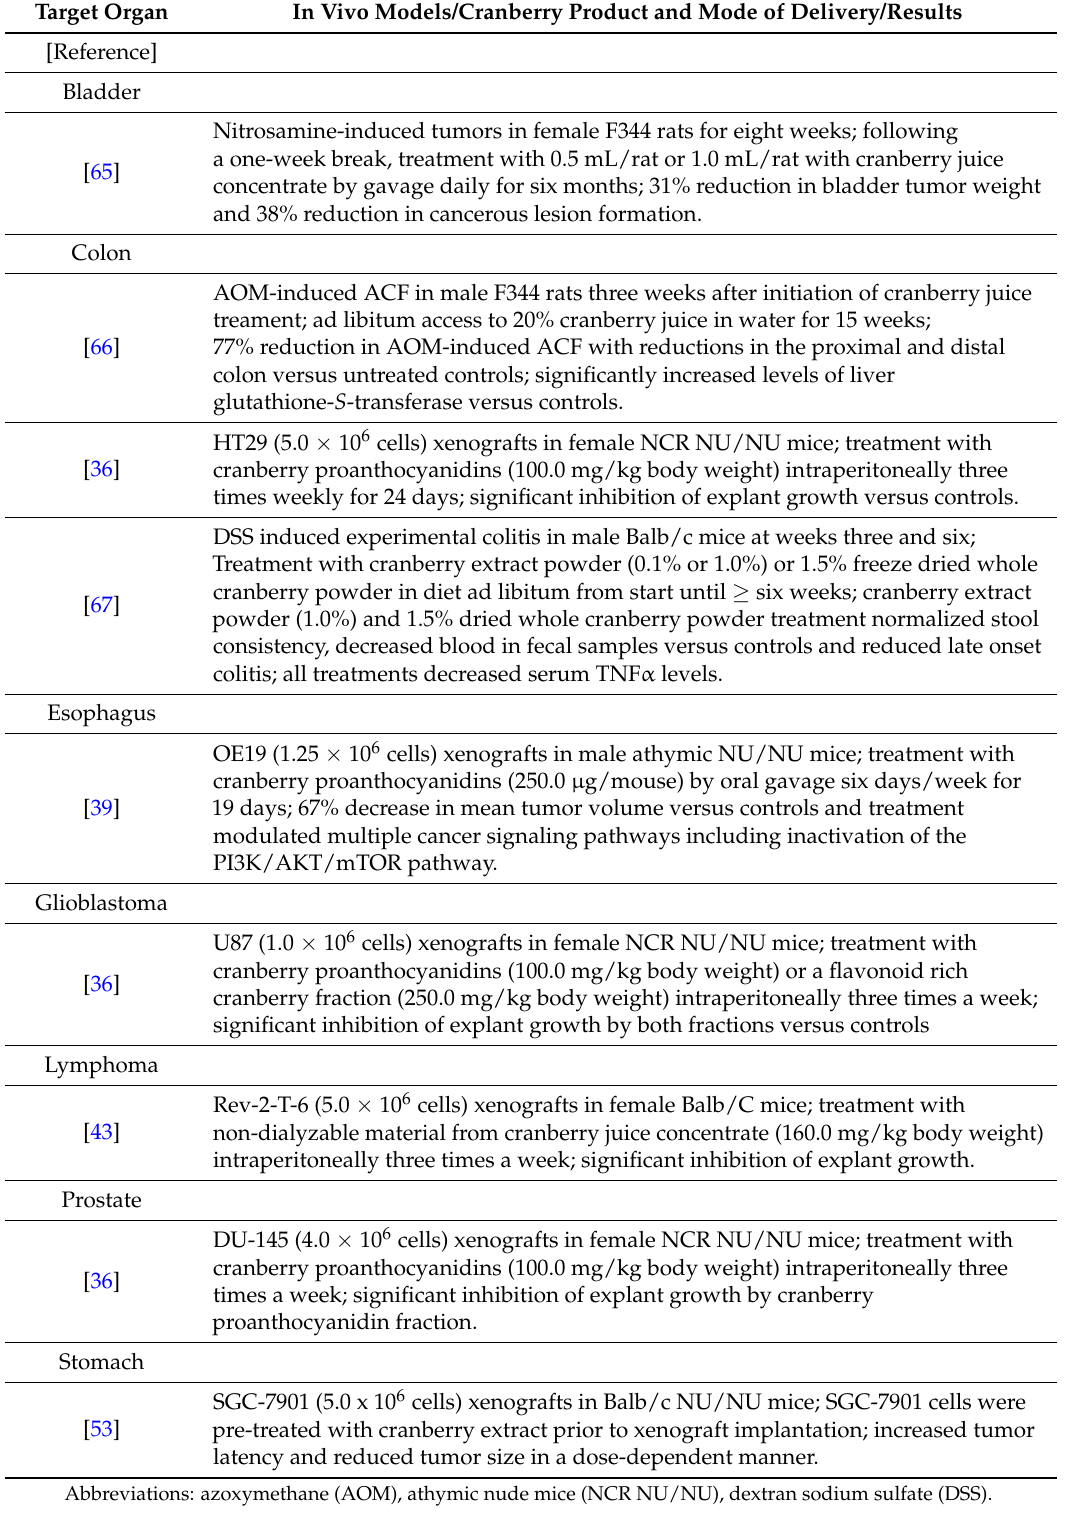
Table 2. Summary of preclinical in vivo evaluations of cranberry products as cancer